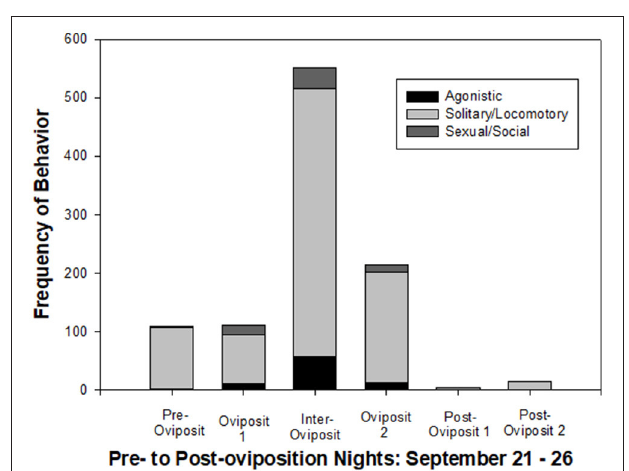
FIGURE 5 | Summary of frequencies of behavioral transitions across the six nights of the study, which included one night each, including pre-oviposition, oviposition night 1 (2 breeding events), inter-oviposition, oviposition night 2 (1 breeding event), and two nights post-oviposition. Agonistic behaviors were Bites, Charges, Chases and Flight. Solitary/Locomotory behaviors were Walking, Swimming, and Surfacing. Sexual and Social behaviors were Ovipositions, Circling, Tail Swishes, Approach, and